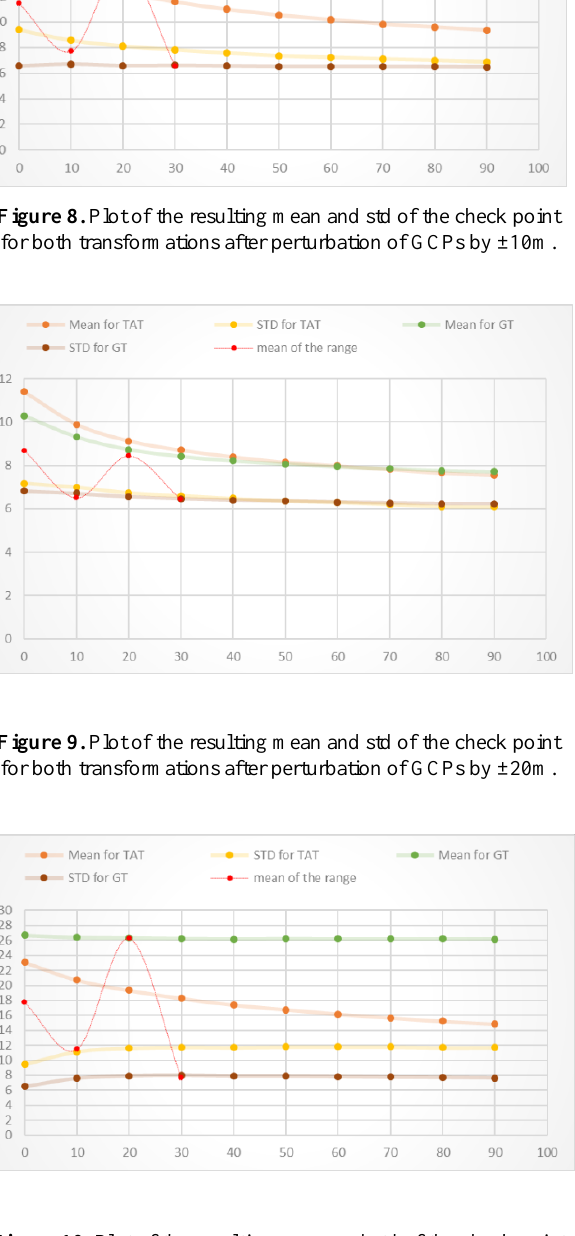
Figure 10. Plot of the resulting mean and std of the check point for both transformations after perturbation of GCPs by ±30m.